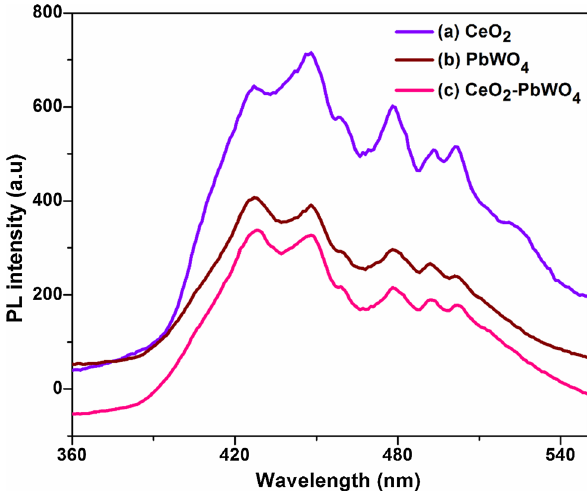
Fig. 7 Photoluminescence emission spectra of as-prepared samples